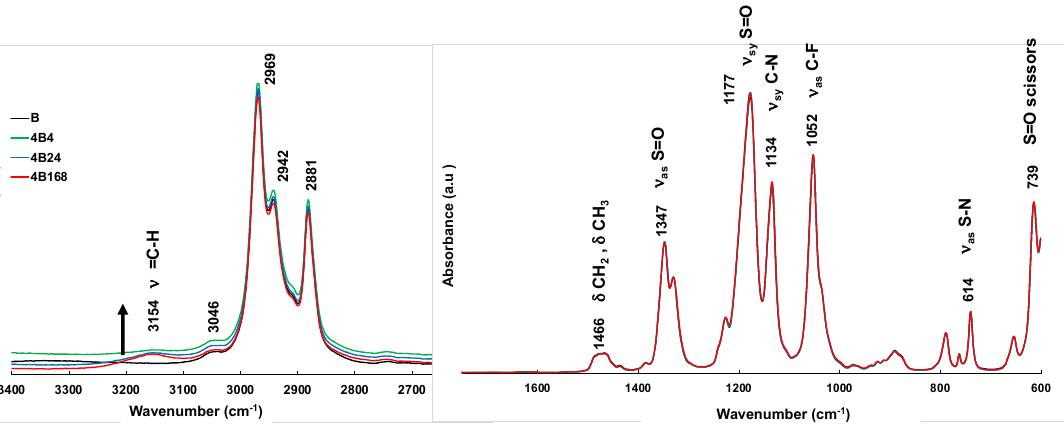
Figure 2. Representative ATR-FTIR spectra of B, 4B4, 4B24 and 4B168 samples in the 3400–2650 and 1740 − 600 cm − 1 regions.